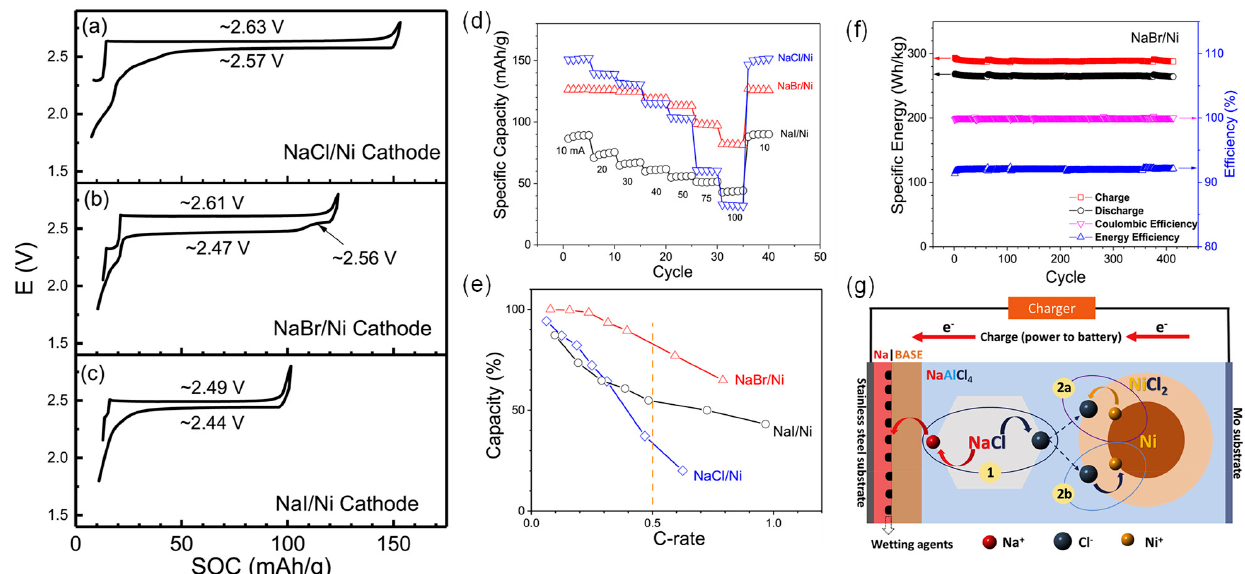
Figure 6. ( a – c ) Typical voltage profiles during the conditioning cycles for the ( a ) NaCl/Ni, ( b ) NaBr/Ni, and ( c ) NaI/Ni cathodes. The current density is 3.3 mA/cm 2 for both charge and discharge, equivalent to ~C/16, ~C/13, and ~C/10 for NaCl/Ni, NaBr/Ni, and NaI/Ni, respectively, and ( d ) plots of the corresponding rate performance in terms of discharge capacity. ( e ) Capacity retention vs. C-rate for NaCl/Ni, NaBr/Ni, and NaI/Ni cells. ( f ) Long-term performance of ( c ) NaBr/Ni cell cycled at a current density of 10 mA/cm 2 . ( g ) Schematic view of reaction mechanisms for a Na-NiCl 2 battery during charging (adapted with the permission from Elsevier).